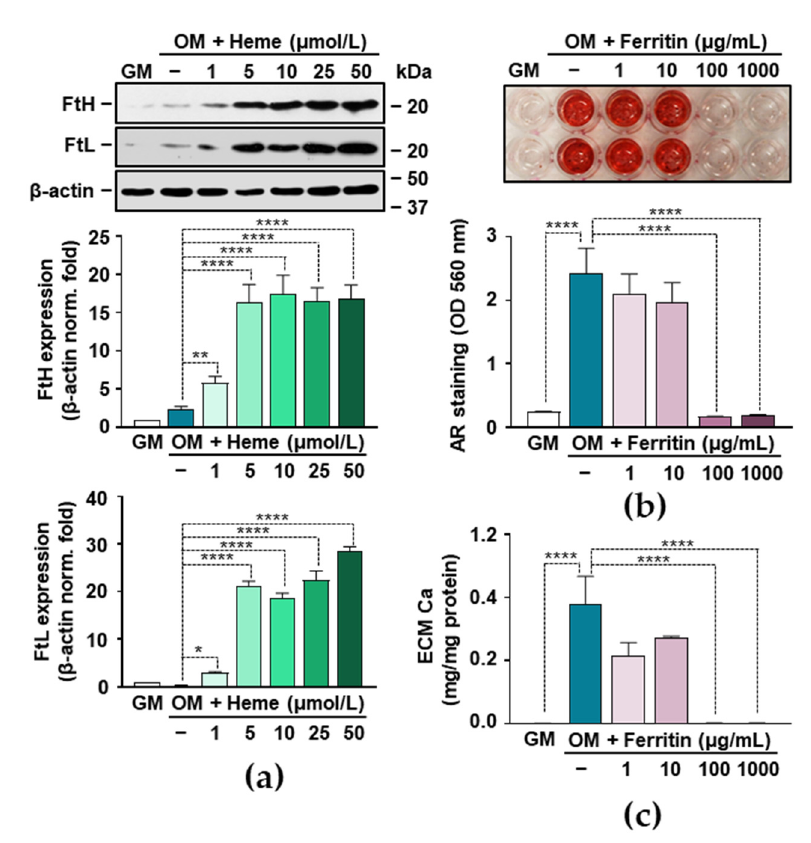
Figure 6. Ferritin mimics the effect of heme in inhibiting the mineralization of VICs. ( a ) VICs (passage number 5–8) were treated with GM or OM, in the absence or presence of heme (1–50 µ mol/L) for 12 h. Expression of H and L chains of ferritin (FTH and FTL) were determined by Western blot. Immunoblots were reprobed with β -actin and are representative of three independent experiments. ( b , c ) VICs were treated with GM and OM, in the presence or absence of ferritin (1–1000 µg/mL) for 5 days. ( b ) Representative AR staining out of three independent experiments and quantification (day 5) are shown. ( c ) Ca content of HCl-solubilized ECM is shown. Results are expressed as mean ± SD from three independent experiments performed in triplicate. * p < 0.05, ** p < 0.01, **** p < 0.001.